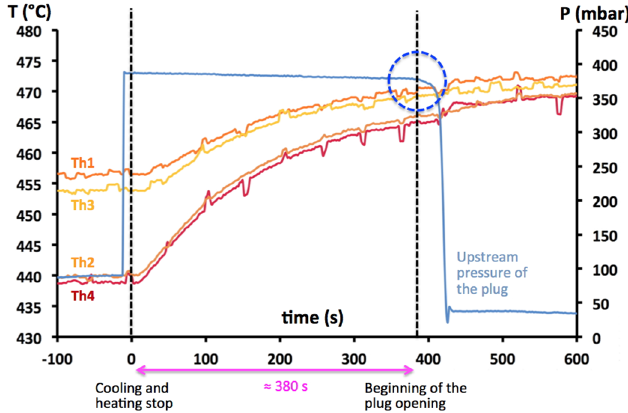
Fig. 13. Temperature and pressure measurements obtained from the cold plug device opening stage experiment. The four thermocouples are inserted in steel masses very near to the copper disk (8mm above for Th1 and Th3, 20mm below for Th2 and